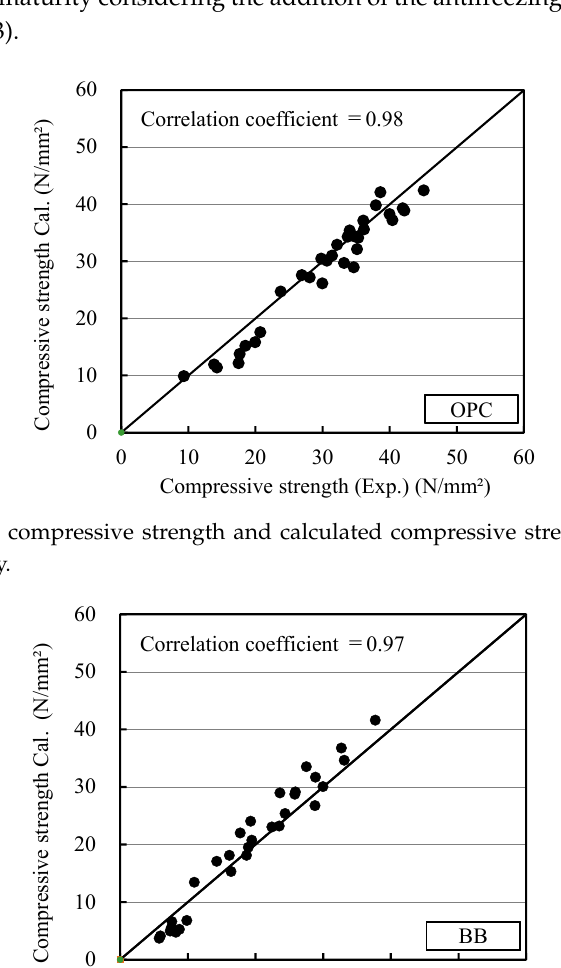
Figure 10. Relation between maturity and compressive strength (BB): Proposal equation for this study,( a )BB-0;( b )BB-2;( c )BB-4;( d )BB-6.